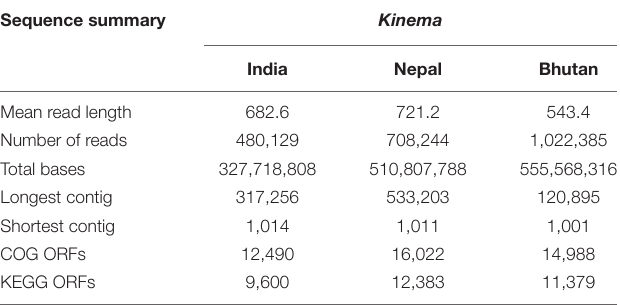
TABLE 1 | General summary and details of metagenomic sequences and assembly